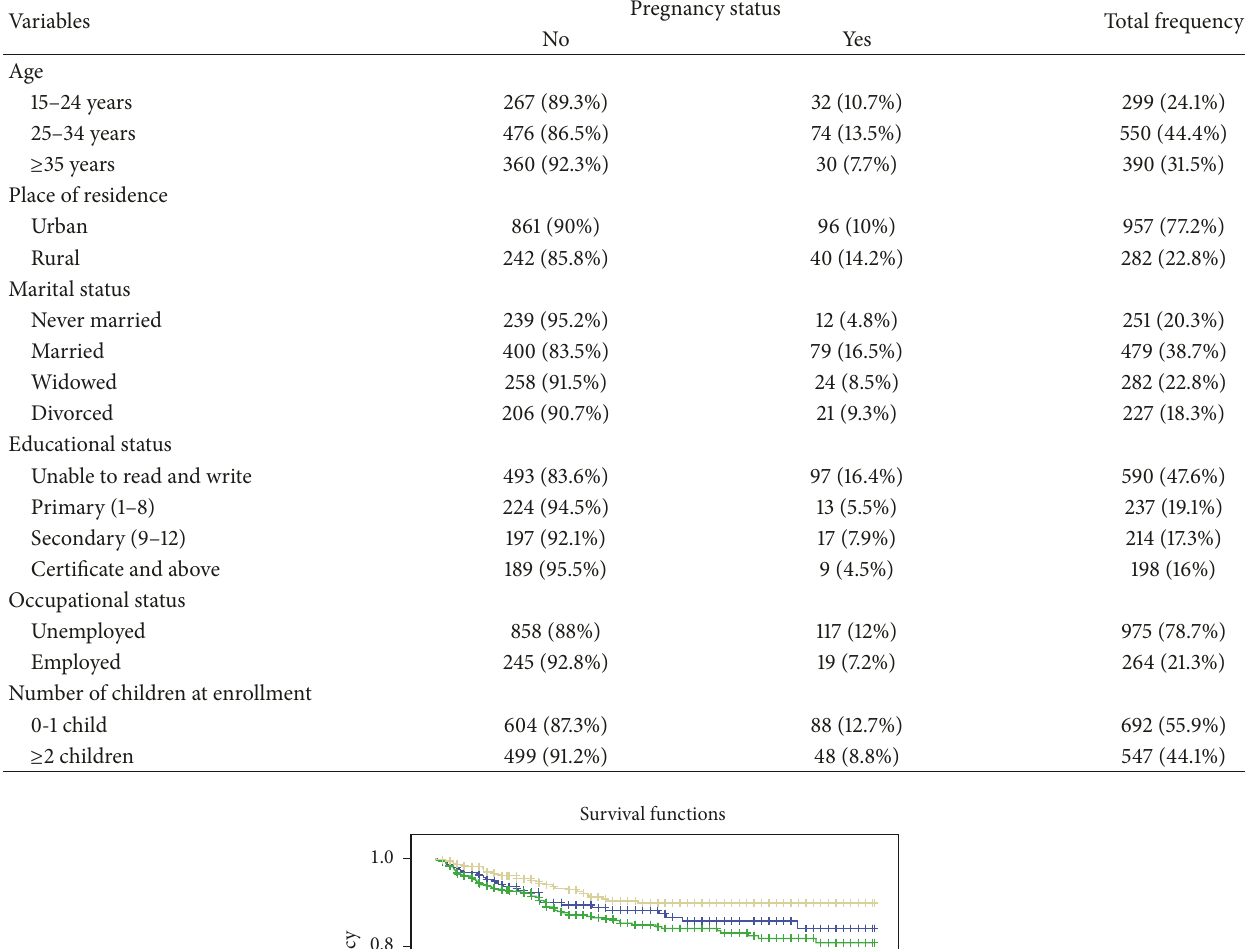
Table 1: Sociodemographic characteristics of women receiving ART treatment from Sep. 2011 to Aug. 2015 in Debre Markos Referral Hospital, Northwest Ethiopia, 2016 (𝑁 = 1239) .